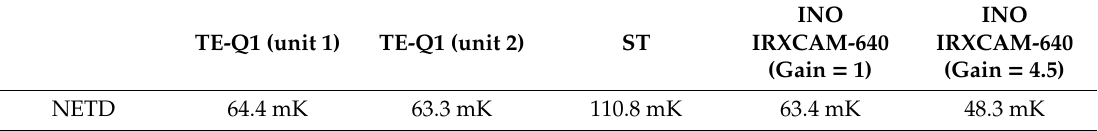
Table 5. NETD results at T amb = 25 ◦ C and blackbody temperature T obj = 27 ◦